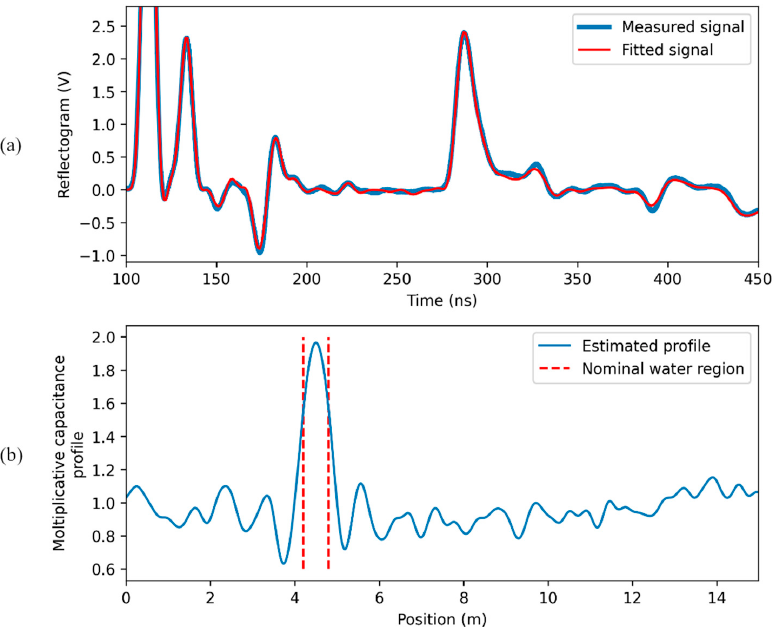
Figure 7. Results of the “direct water-leak estimation” in the case of a strong reflected pulse: ( a ) measured and fitting signal; ( b ) estimated capacitance profile. ( a ) measured and fitting signal; ( b ) estimated capacitance profile.